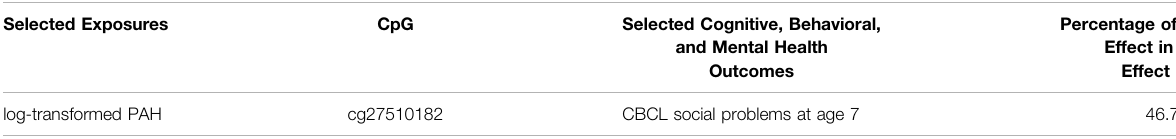
TABLE 5 | Mediation analysis of selected paths of exposure-CpG-outcome (Results from Step 5). Selected Exposures